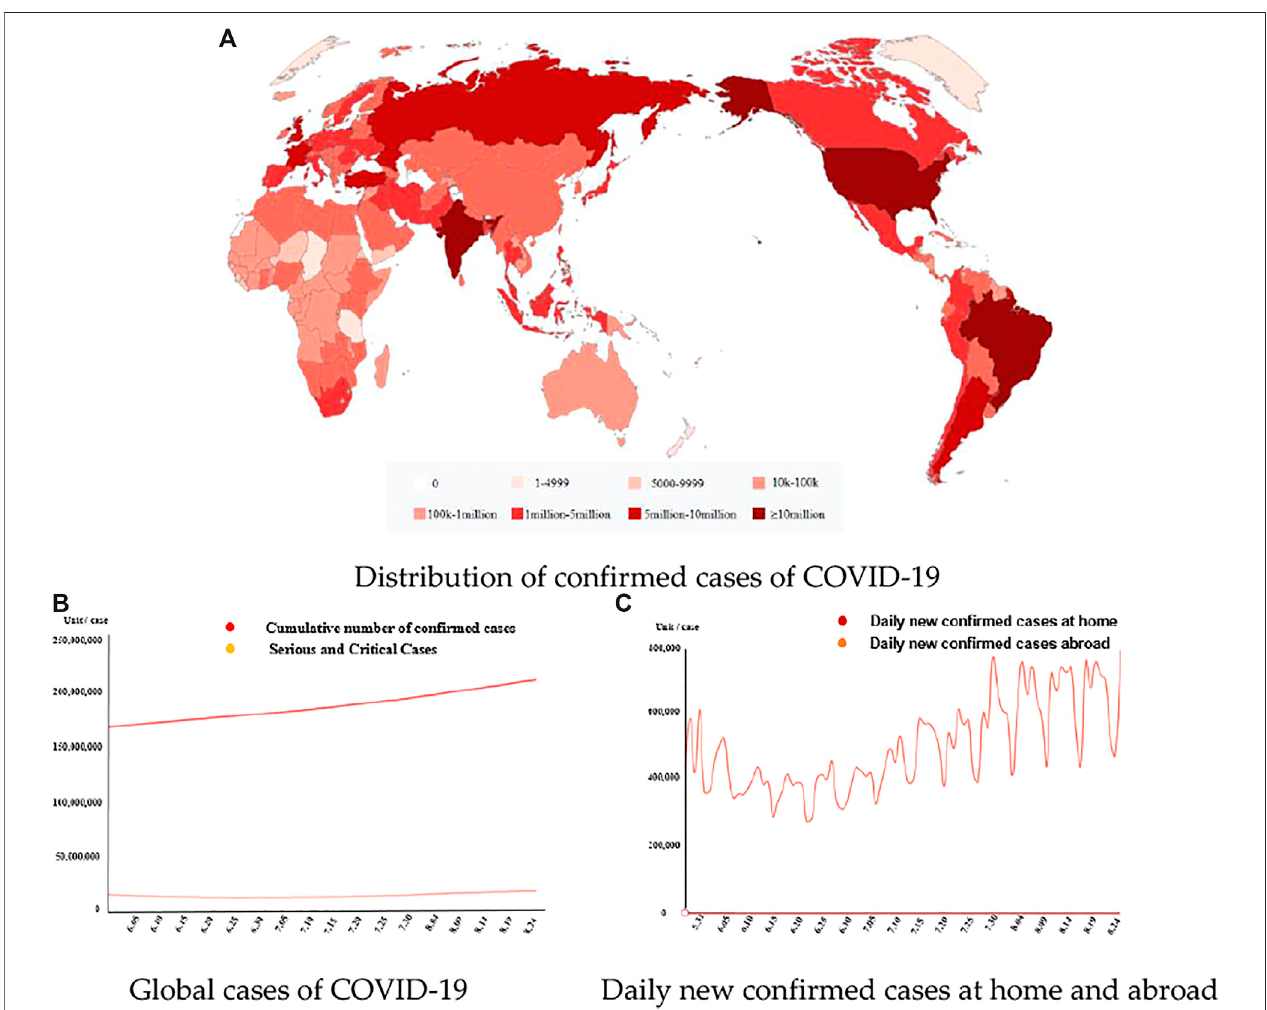
FIGURE 1 | COVID-19 situation worldwide and in China (updated August 25, 2021). (A) Distribution of con fi rmed cases of COVID-19; (B) Global cases of COVID- 19; (C) Daily new con fi rmed cases at home and abroad.